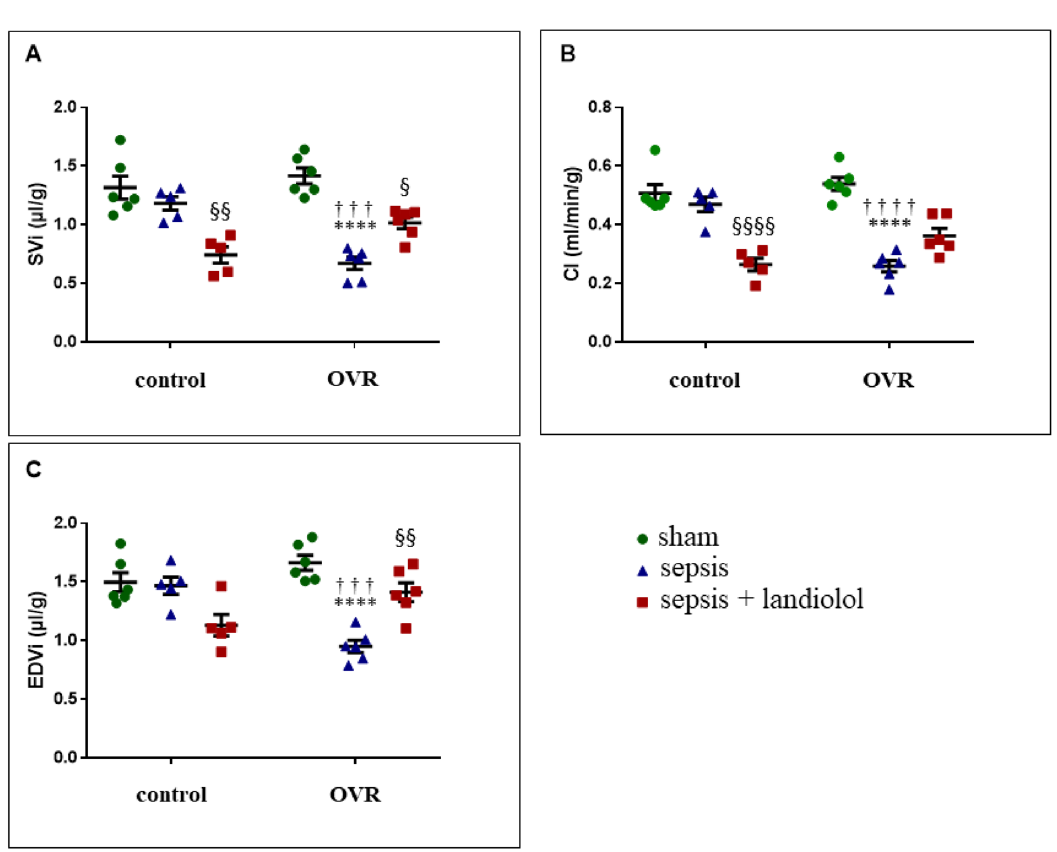
Figure 2. Left ventricular cardiac parameters assessed by MRI of sham (n = 6), sepsis (n = 5), sepsis plus landiolol (n = 5), OVR-sham (n = 6), OVR-sepsis (n = 6) and OVR-sepsis plus landiolol (n = 6). ( A ) Indexed stroke volume (SVi). ( B ) Cardiac index (CI). ( C ) Indexed end-diastolic volume (EDVi). Data are expressed as means ± SEM. ****p < 0.0001 vs sham and vs OVR-sham, respectively. § p < 0.05; §§ p < 0.01; §§§§ p < 0.0001 vs sepsis and OVR-sepsis, respectively. ††† p < 0.001; †††† p < 0.0001 vs control of corresponding